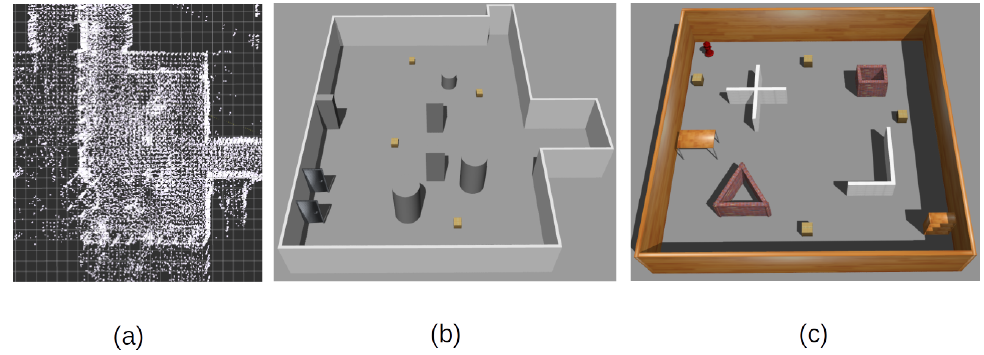
Figure 3. ( a ) Point cloud mapping of the cleaning environment in Riga Technical University. ( b ) ROS Gazebo simulated representation for expert demonstration collection. ( c ) ROS Gazebo simulated environment used for training of the neural